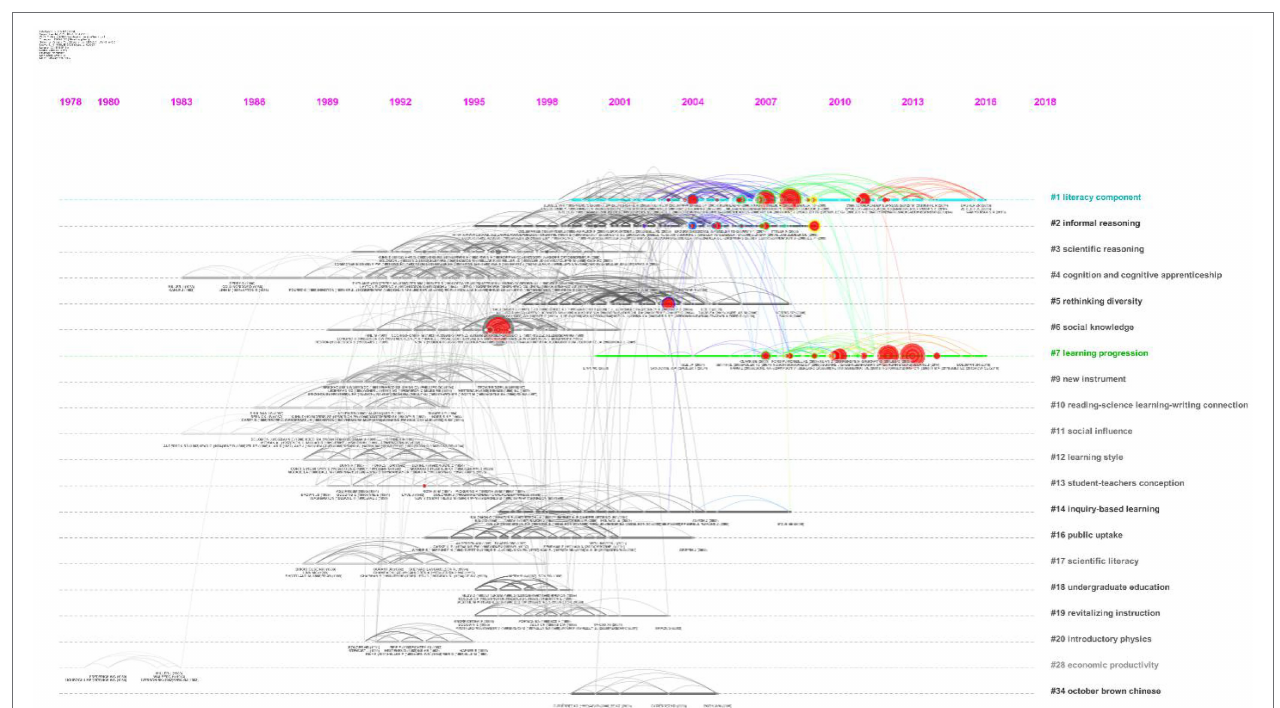
FIGURE 5 | Co-citation-based cluster analysis of the intellectual field of scientific literacy between 1980 and